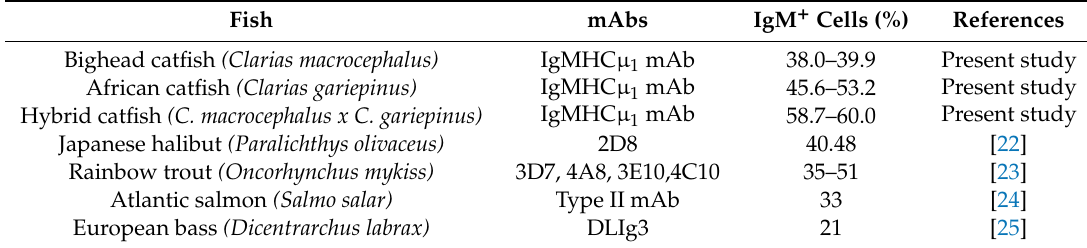
Table 1. Percentage of IgM + cells in peripheral blood leukocytes of teleost